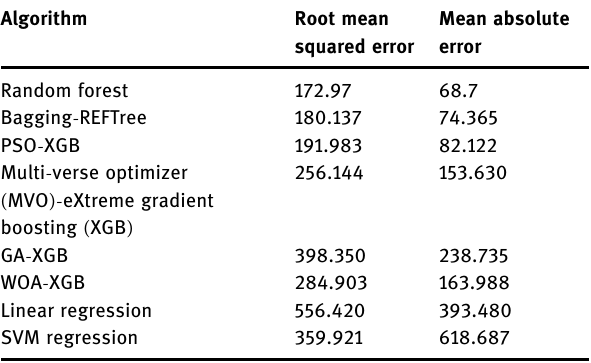
Table 6: Error forecasting results for the techniques used Algorithm